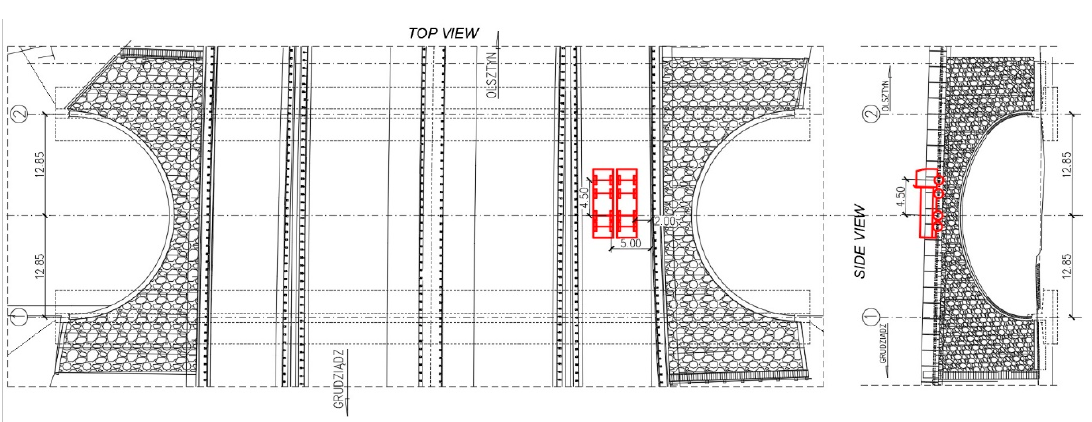
Figure 11. Schematic drawing of trucks locations at M24 stop (dimensions in (m)).